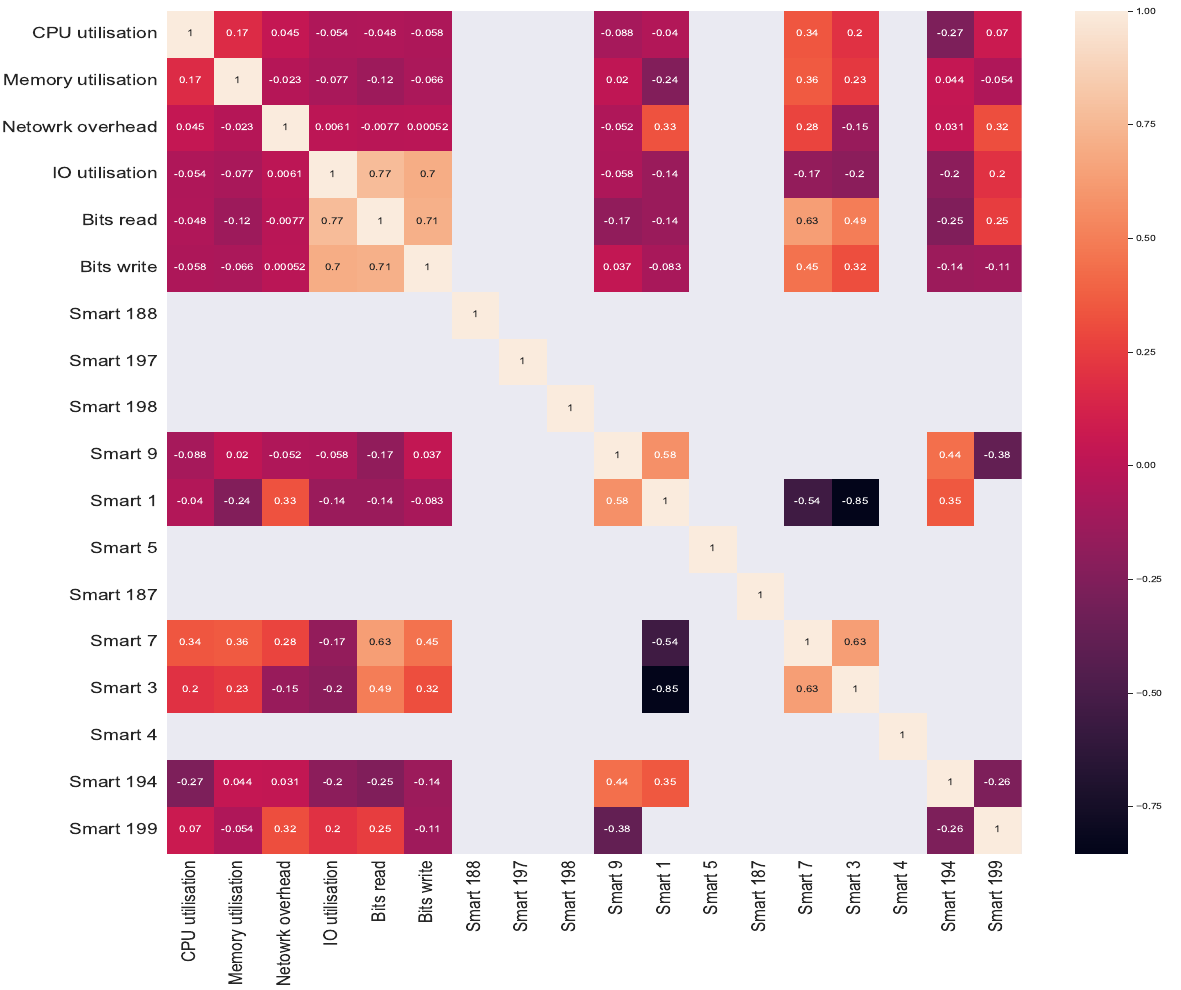
Figure 11. Kendall’s tau correlations between system